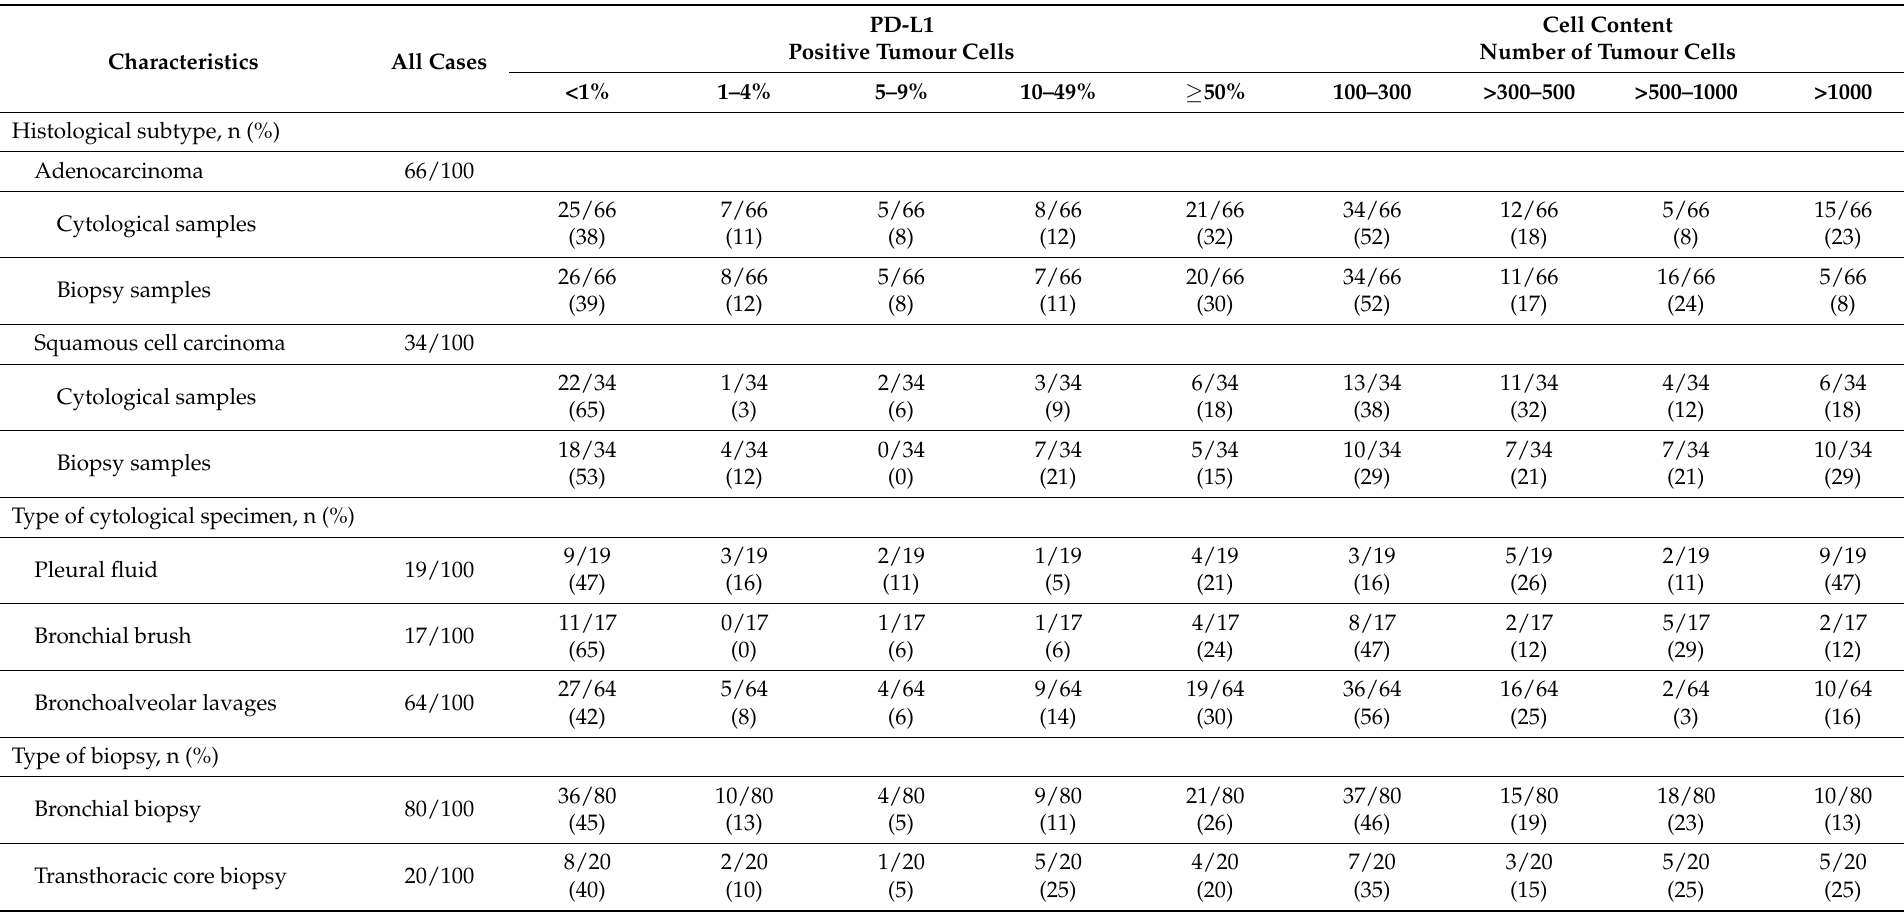
Table 1. PD-L1 expression and cell content in paired histological and cytological non-small cell lung cancer